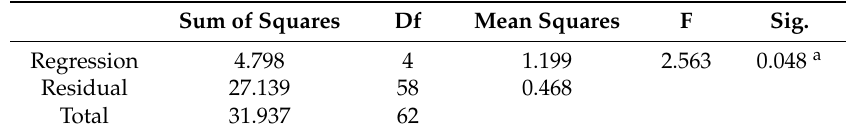
Table 6. The regression analysis of the factors on the functionality evaluation by students. Sum of Squares Df Mean Squares F